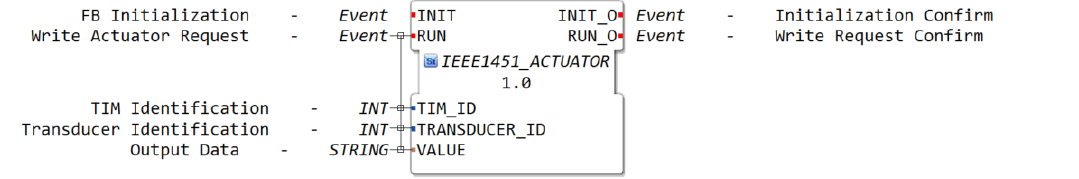
Figure 5. Smart Function Block—IEEE 1451 Actuator.